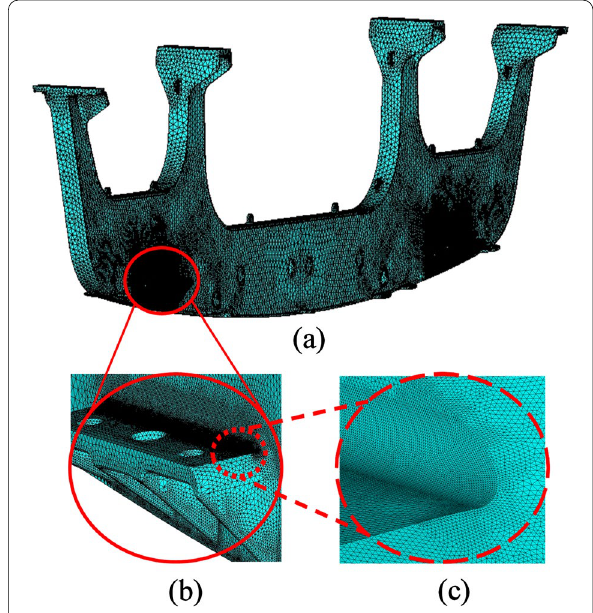
Figure 7 FE model of the cast aluminum beam: a Global view; b Local zoom I—supporting seat #1; c Local zoom II—mesh refinement in the fillet of the supporting seat